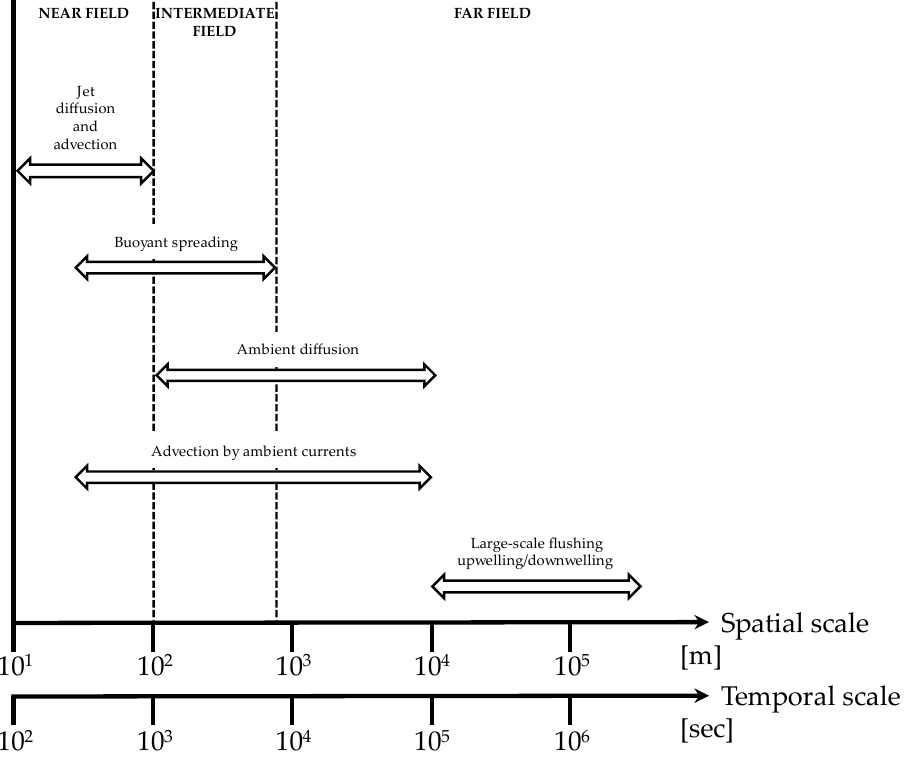
Figure 2. Reference spatial and temporal scales associated with transport and mixing processes of wastewater discharges in the marine environment. Adapted from Bleninger et al. [31].